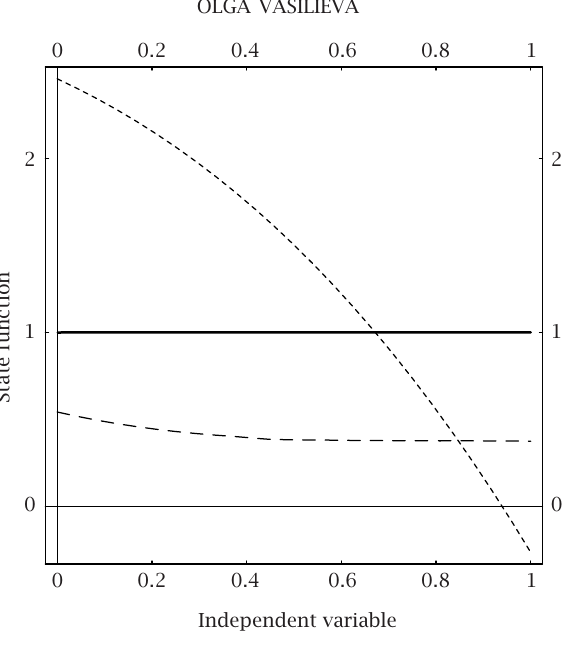
(t) , ¯ x (t) , and ˆ x (t) . Figure 4.1 . State profiles x ∗ 2 2 2 (t) is given by a thick solid line, ¯ x (t) is Figure 4.1 shows three profiles where x ∗ 2 2 drawn by a dashed line, and ˆ x 2 (t) is represented by a dotted line. Thick point in the end of each curve indicates the value of J(u) . Finally, having compared these values, it becomes perfectly clear that u ∗ (t) ≡ 0, t ∈ [ 0 , 1 ] , is not